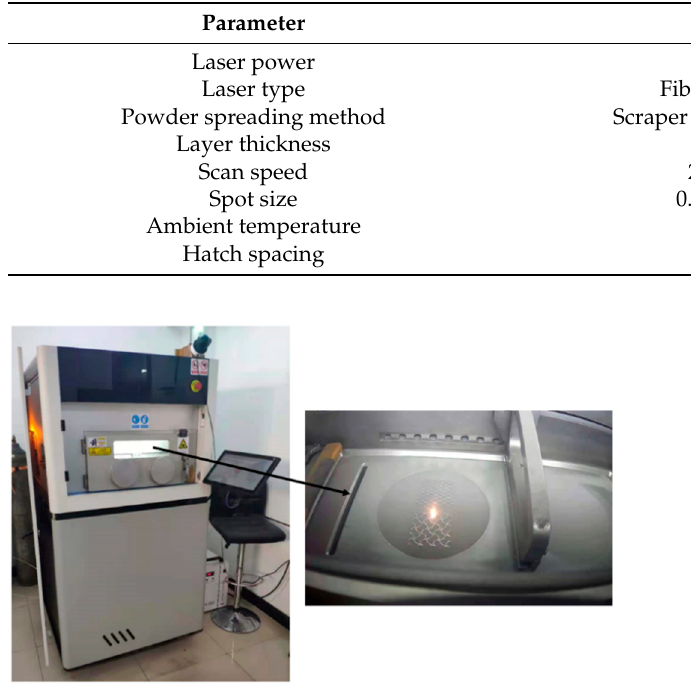
Table 3. SLM process parameters.